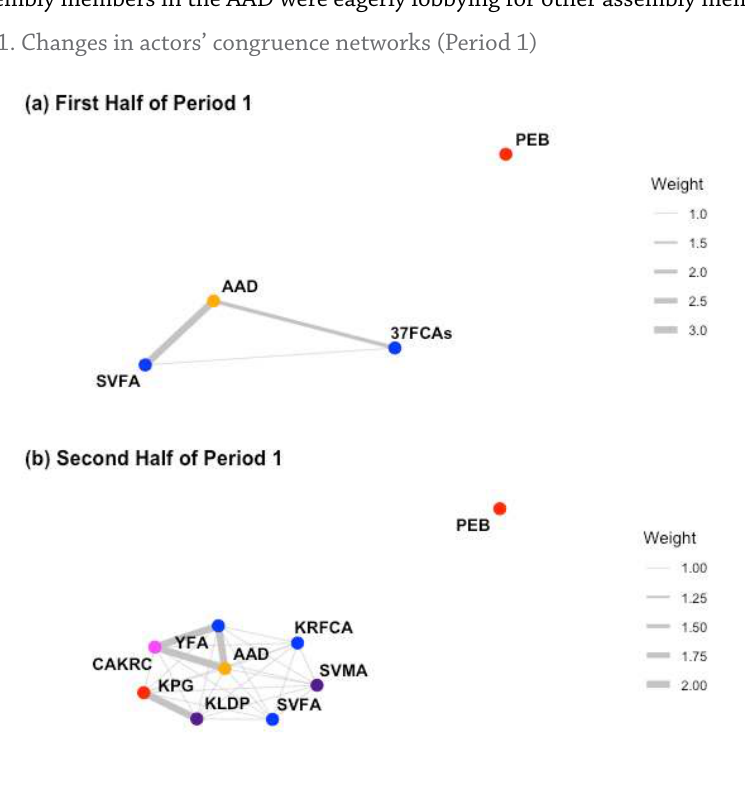
Note: The color of the node indicates each organizational attribute. Blue indicates fisher- men, green indicates farmers, pink indicates NGOs, orange indicates residents' organiza- tions, purple indicates parties and politicians, and red indicates government